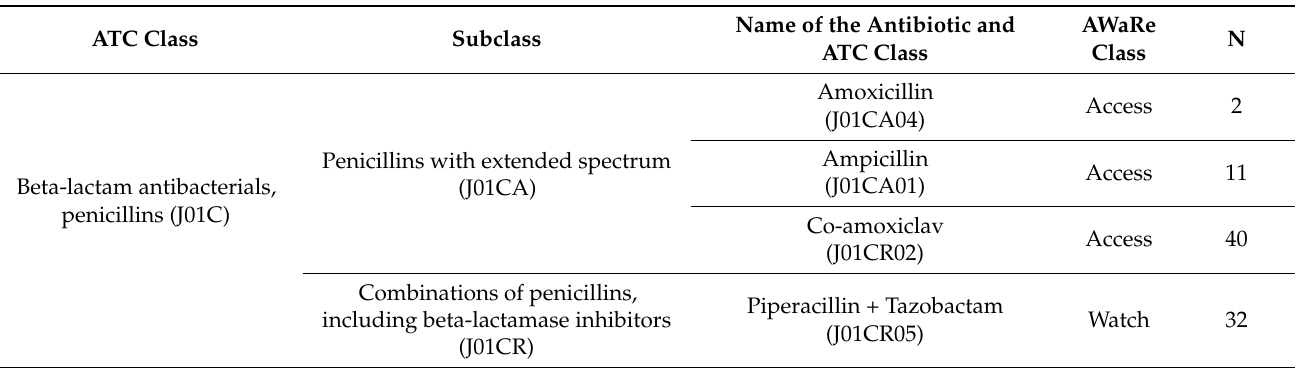
Table 3. Details of prescribed antibiotics according to Anatomical Therapeutic Chemical (ATC) and AWaRe